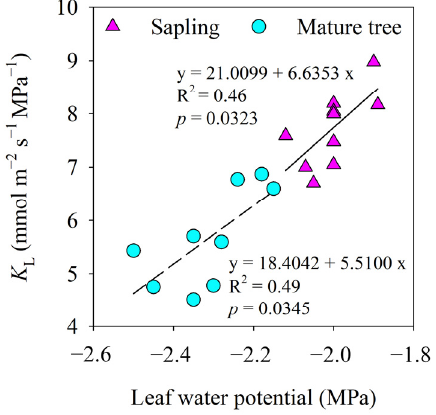
Figure 6. The relationship between leaf water potential and leaf-specific apparent hydraulic conductance ( K L ). Lines indicate significant linear regressions fitted at a p value of < 0.05.